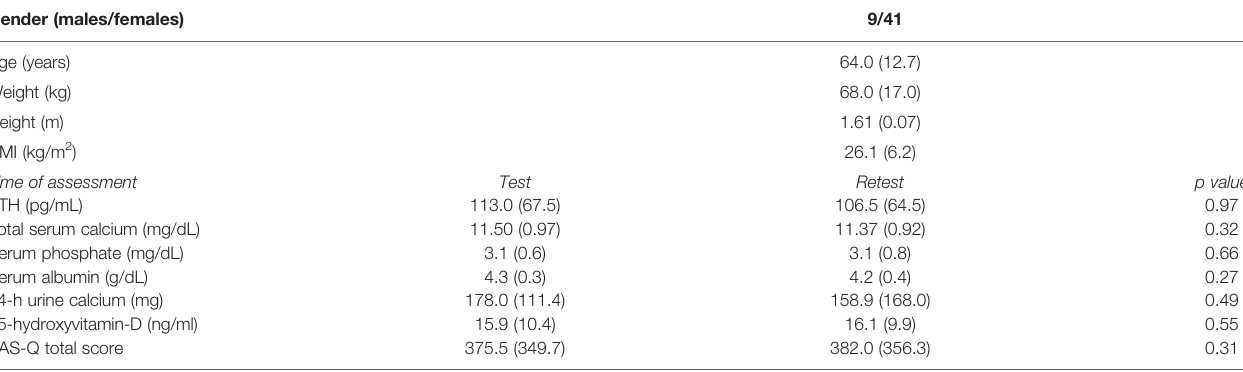
All the data are presented as the median and the interquartile range within the brackets BMI, body mass index; PAS-Q, Pasieka ’ s parathyroid assessment of symptoms questionnaire; PTH, parathyroid hormone.